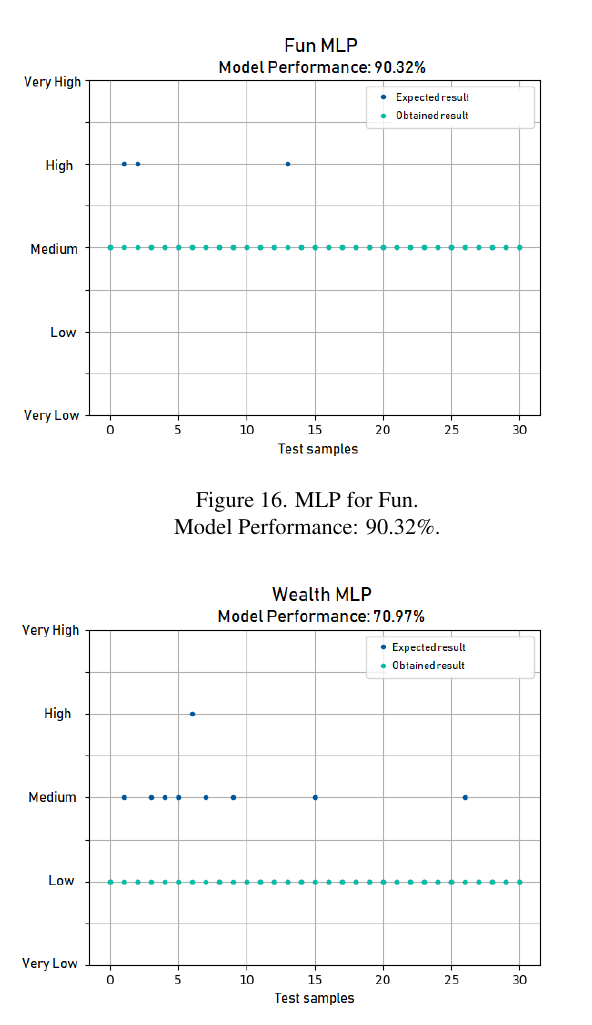
Figure 17. MLP for Wealth. Model Performance: 70.97%.